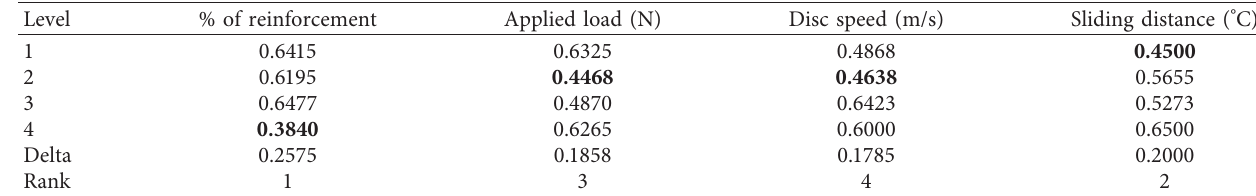
Table 5: Response table for means (wear test)